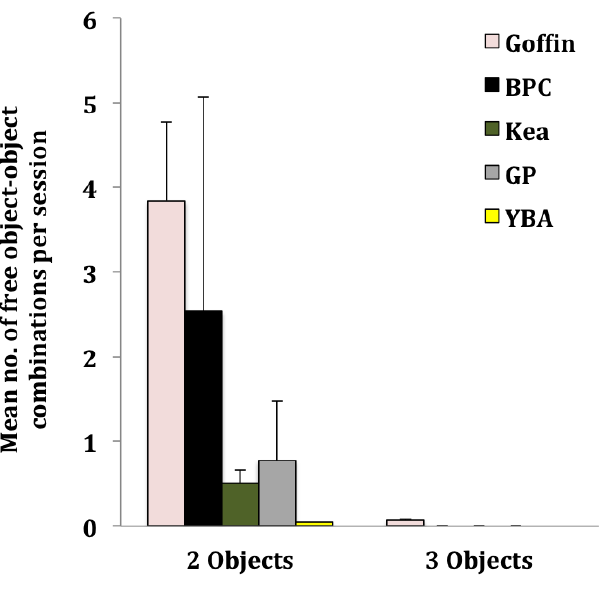
Figure 3. Mean number (± SE) of free object-object combinations of two objects (left) and of three objects (right) per session. The colors of the bar charts indicate different species: rose = Goffin ( N = 14), black = BPC ( N = 2), olive = kea ( N = 14), grey = GP ( N = 10), yellow = YBA ( N =